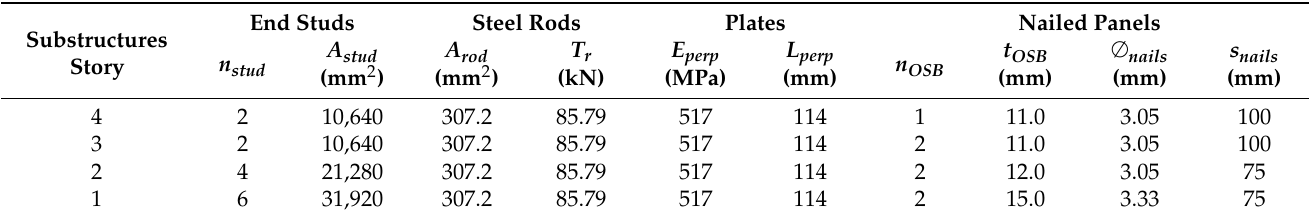
Table 3. Shearwall compositions used to determine the modeled stiffnesses. Note: n stud is the number of members composing the end studs, n OSB is the number of OSB sheets, t OSB is the OSB thickness, ∅ nails is the diameter of nails and s nails is the spacing between nails.